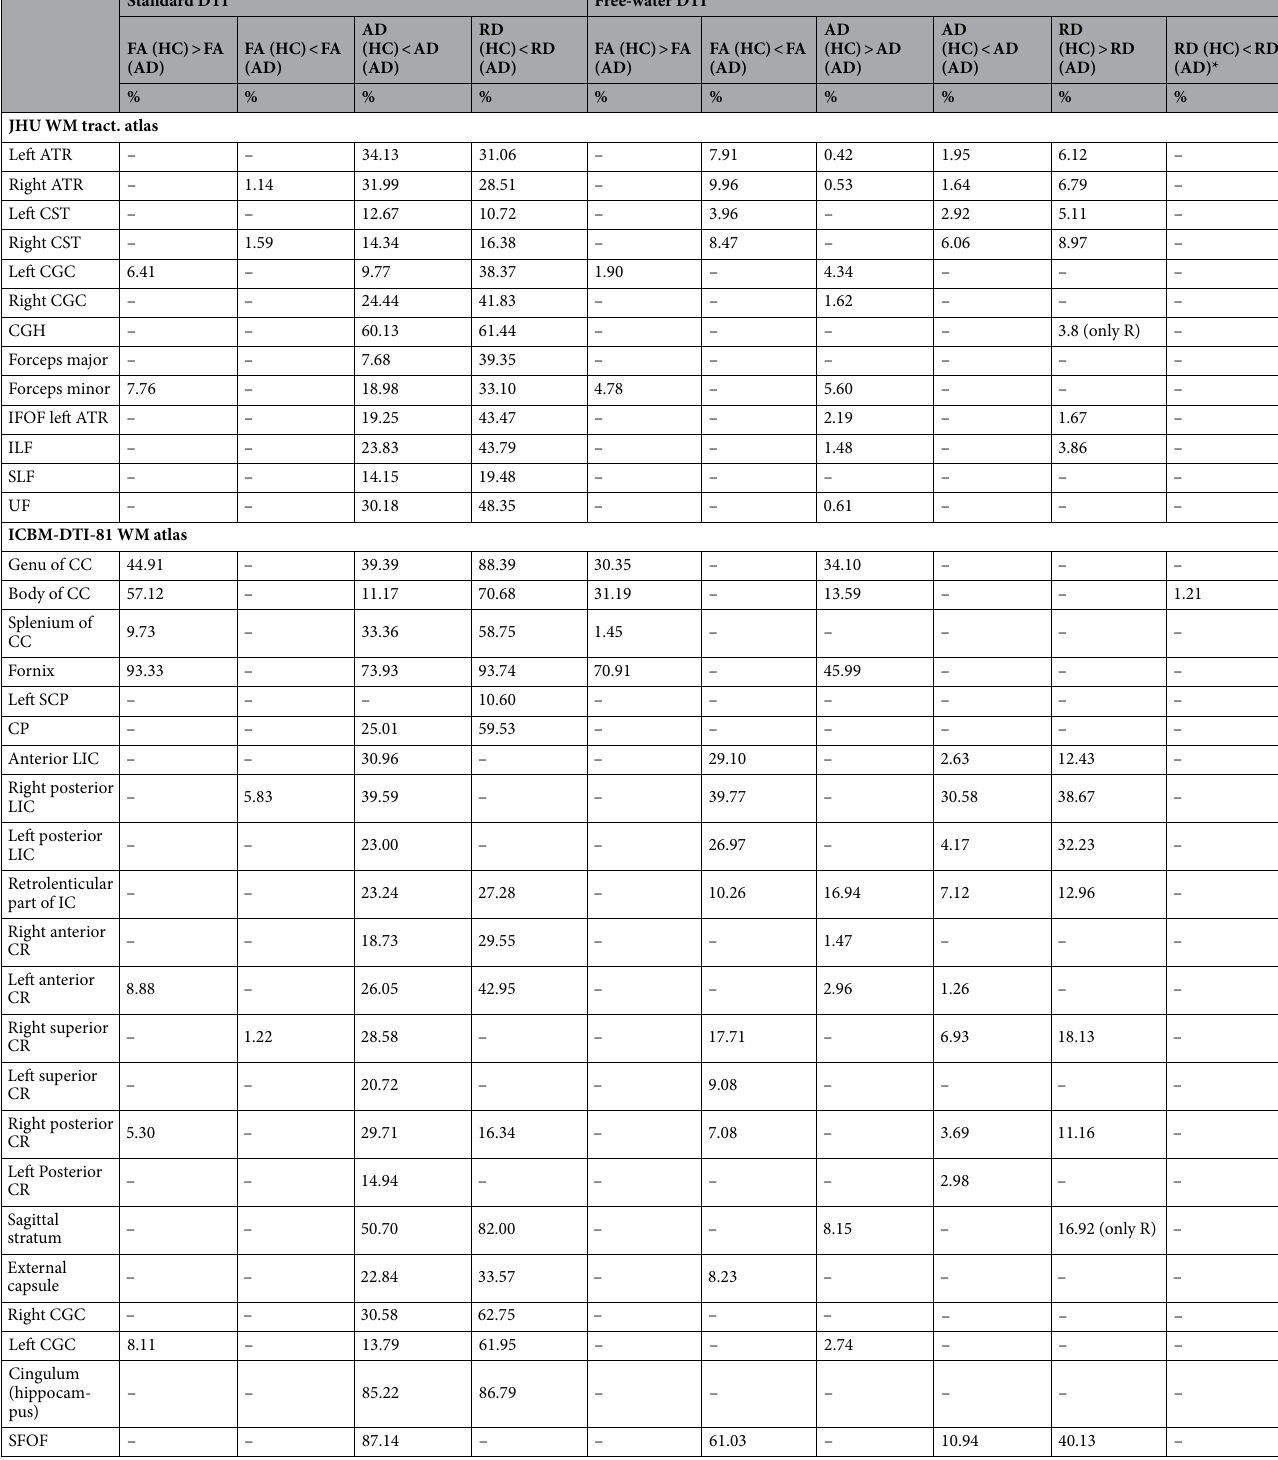
Table 2. Brain locations where clusters of significant differences between groups were found for both standard and FW-DTI analyses. All results are shown for p < 0.01 (FWE corrected), except for the last column, indicated by *, where RD (HC) < RD (AD) is reported at p < 0.05 (FWE corrected). % columns indicate the percent volume of the cluster inside the corresponding brain area. For JHU white-matter tractography atlas: ATR anterior thalamic radiation, CST cortical spinal tract, CGC cingulum (cingulate gyrus part), CGH cingulum (hippocampal part), IFOF inferior fronto-occipital fasciculus, ILF inferior longitudinal fasciculus, UF uncinate fasciculus. For ICBM-DTI-81 white-matter atlas: CC corpus callosum, LIC limb of internal capsule, IC internal capsule, CR corona radiate, SS sagittal stratum, SFOF superior fronto-occipital